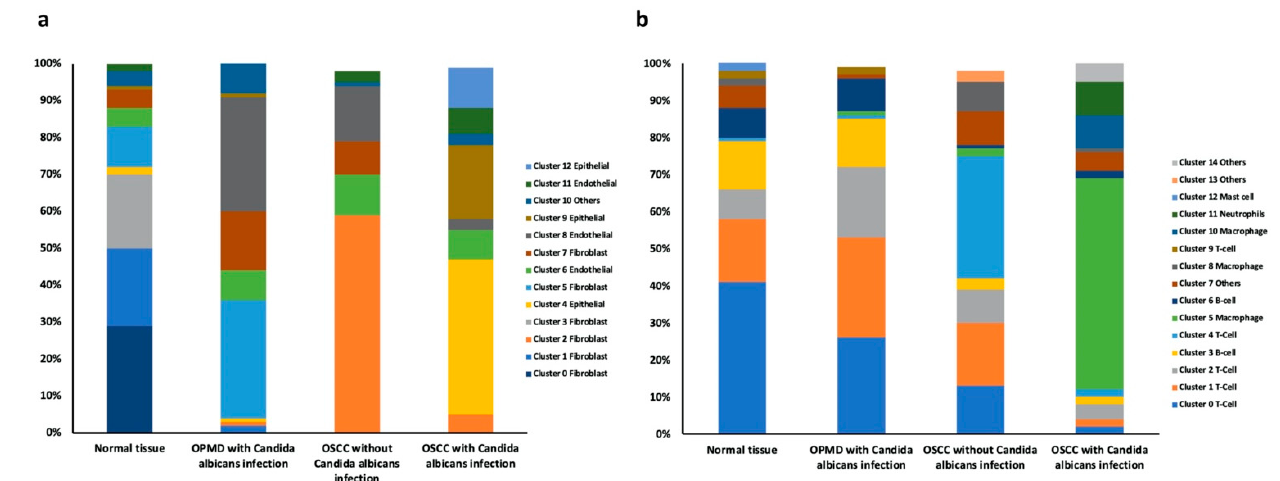
Figure 4. Comparison of the compositions of cell subtypes within the normal tissue, OPMD lesion with Candida albicans infection, OSCC tissue with C. albicans infection, and OSCC tissue without C. albicans infection. ( a ) Cancer-related cell ratios and ( b ) Immune cell ratios of these clusters within the four groups.